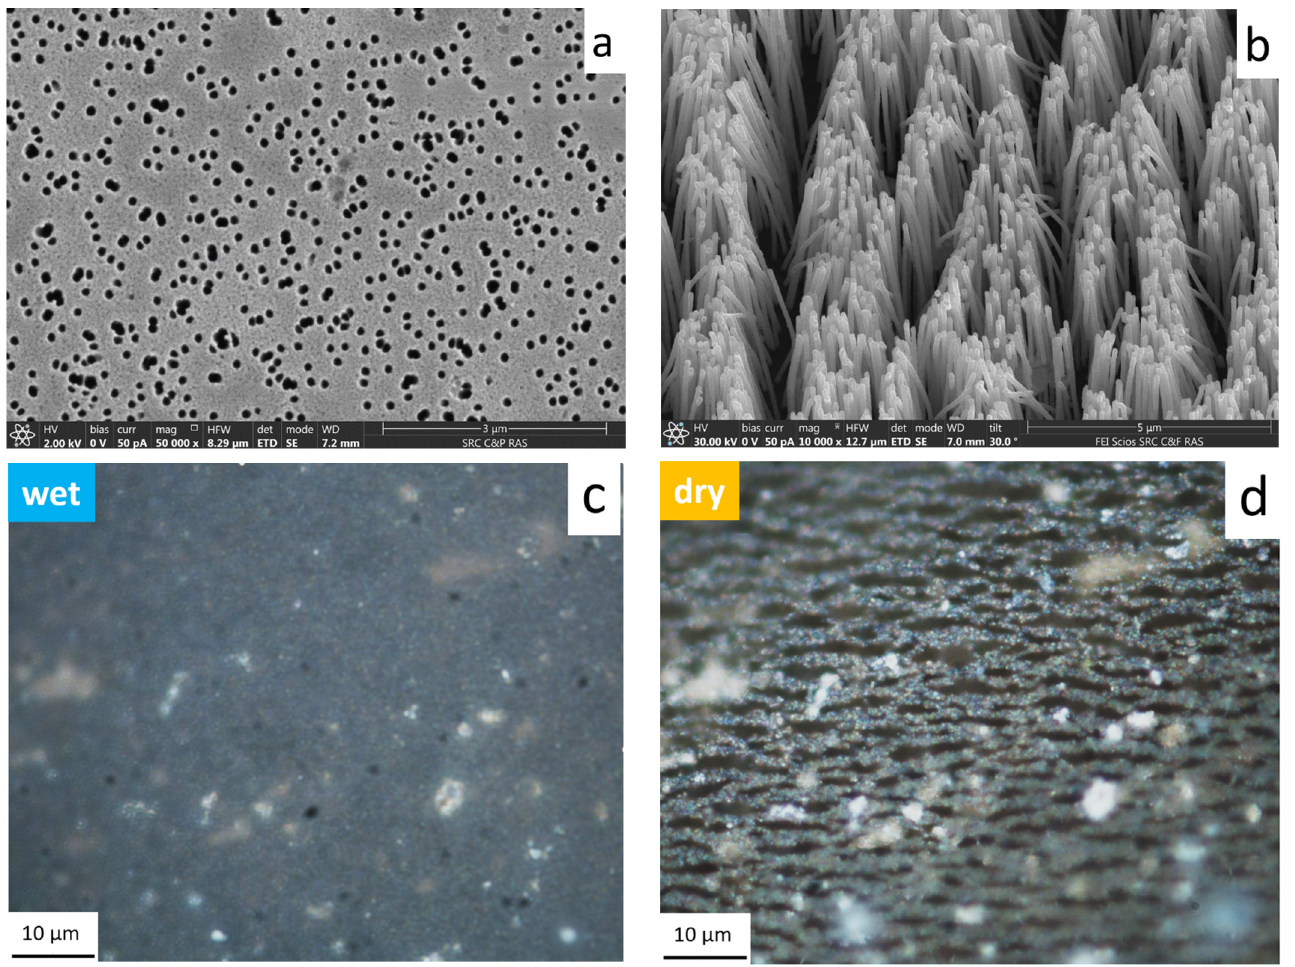
Figure 3. SEM top view of the TM ( a ) and the surface of the substrate with an Ag ‐ NWs bundles array with an Ag ‐ NWs diameter of 100 nm and their length of 12 μ m. SEM top view of the Ag ‐ NWs bundles array ( b ). Photos of the substrate are made by optical microscope ( c ) when it is in a wet state, ( d ) of the same area after drying. It was found that the largest length corresponds to bundles with a greater number of Ag ‐ NWs due to their high elasticity. As a result, bundles consisting of dozens of densely leaned Ag ‐ NWs formed without the breakaway of the Ag ‐ NWs from the substrate. With a decrease in the length of the Ag ‐ NWs, the number forming the bundle became smaller, and at a length in the range of 1.5–3 μ m it was possible to observe single leaning Ag ‐ NWs.